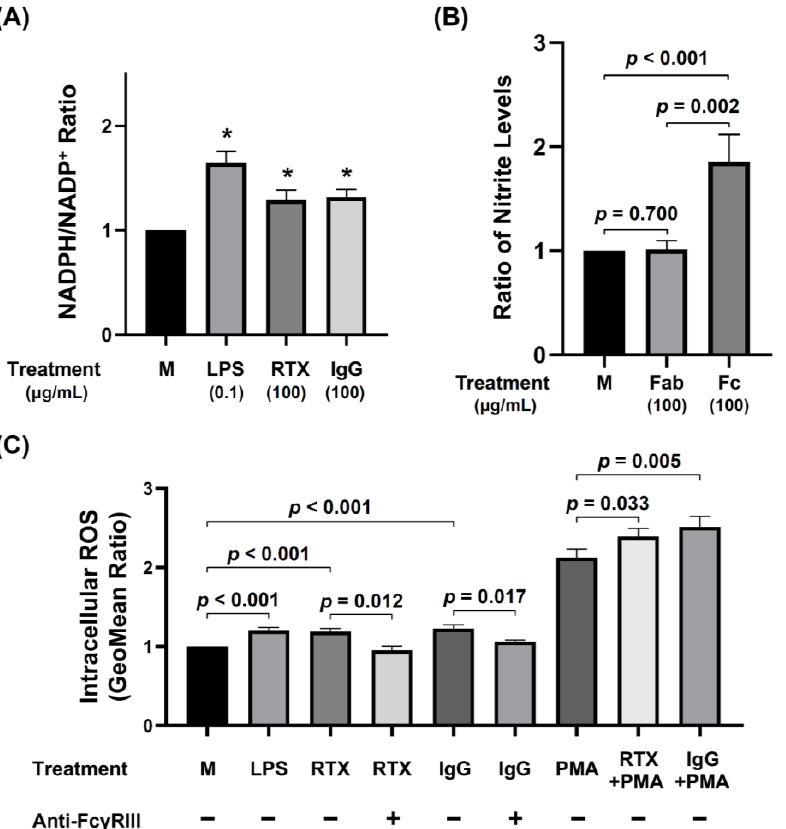
Figure 5. Increased dHL-60 ROS production by monomeric IgG and rituximab (RTX, IgG1 subclass) Fc region engagement per se. ( A ) Compared to medium control (M), RTX and normal human IgG per se significantly enhanced NADPH/NADP+ ratio. ( B ) IgG Fc fragment (100 μg/mL), but not Fab fragment (100 μg/mL) , engagement significantly enhanced nitrite production from dHL-60. ( C ) Anti- FcγRIII antibody (5 μg/mL) pretreatment significantly inhibits IgG (200 μg/mL) and RTX (200 μg/mL) -enhanced intracellular ROS generation. In addition, the engagement of IgG and RTX can augment PMA-stimulated intracellular ROS generation by dHL-60. * p < 0.05 compared to the medium control (M).